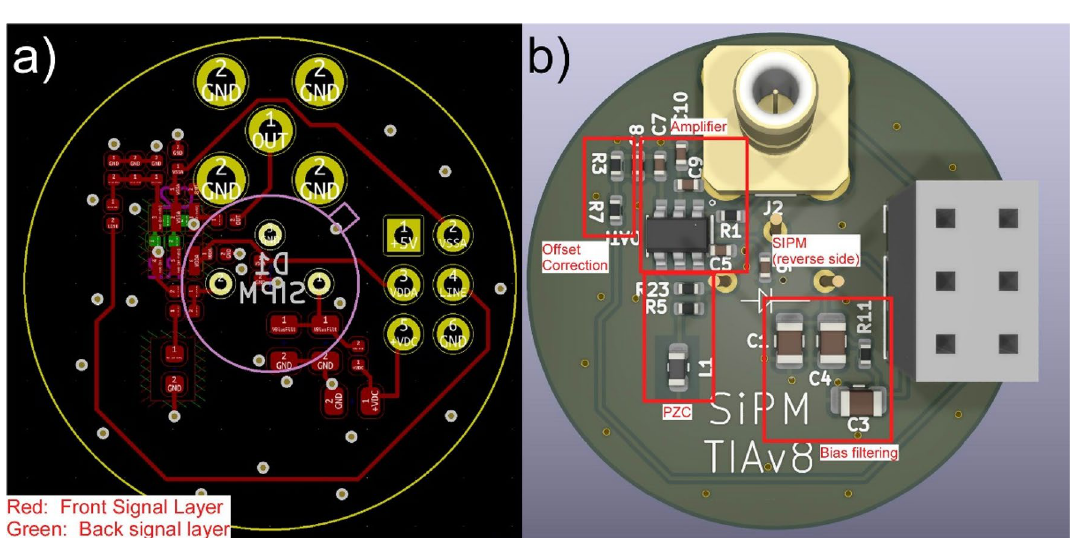
Figure 2. High dynamic range SiPM amplifier design. ( a ) Signal traces for the amplifier PCB. The bias voltage is filtered by a second order RC filter whose cutoff frequency depends on bias voltage but attenuates the 1 MHz switching frequency of the boost converter by more than 70 dB at 50v. A Hamamatsu S14420 is mounted on the reverse side. ( b ) Amplifier board with annotated component